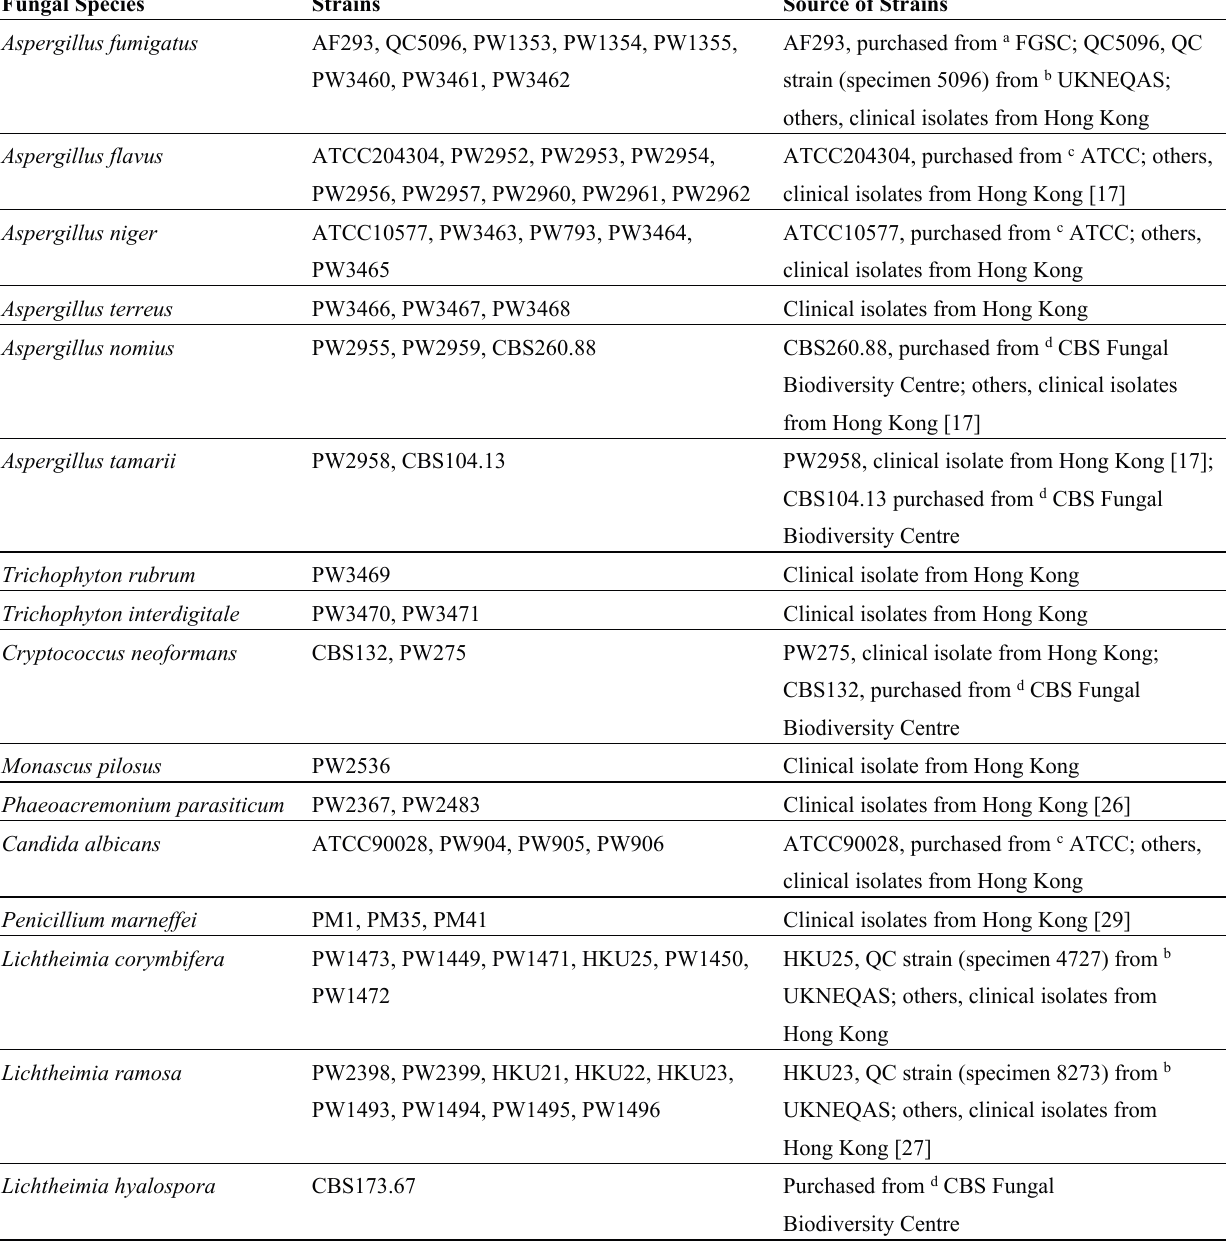
Table 3. Fungal strains used in this